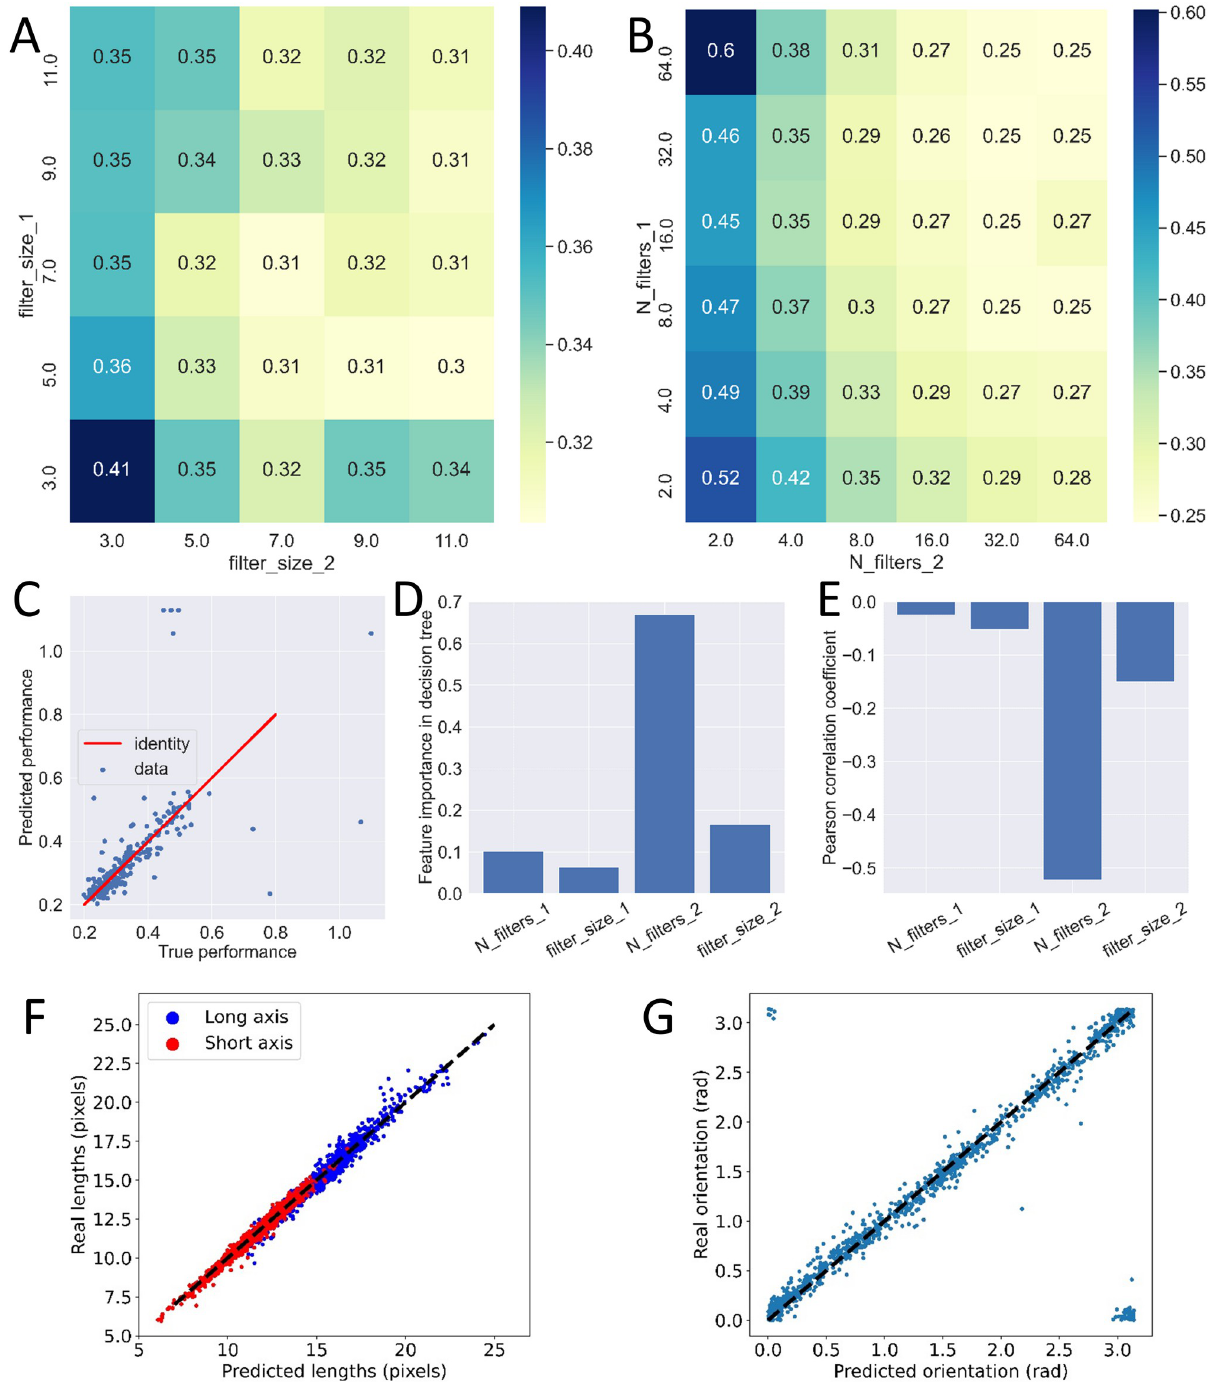
Fig 5. Grid search on 2-conv models. A: Effect of filter size in each layer. The averaged MAE shown in colors and numbers. B: same study for the effect of number of filters in both layers. Numbers in A and B represent the same quantity as in Fig 4A. C: comparison between true performance of 2-conv models and the performance predicted by a decision tree regressor. The red line is a guide for the eye representing identity. D: feature importance of all four parameters in the decision tree regressor. E: Pearson correlation coefficient of all parameters with the performance of the models. Negative values indicate that increasing any of these parameters will tend to reduce the MAE and hence increase performance. F: comparison of predicted and true long and short axes for the re-trained optimal 2-conv model. G: comparison of predicted and true orientation for the same model. In F and G, the dashed black line represents